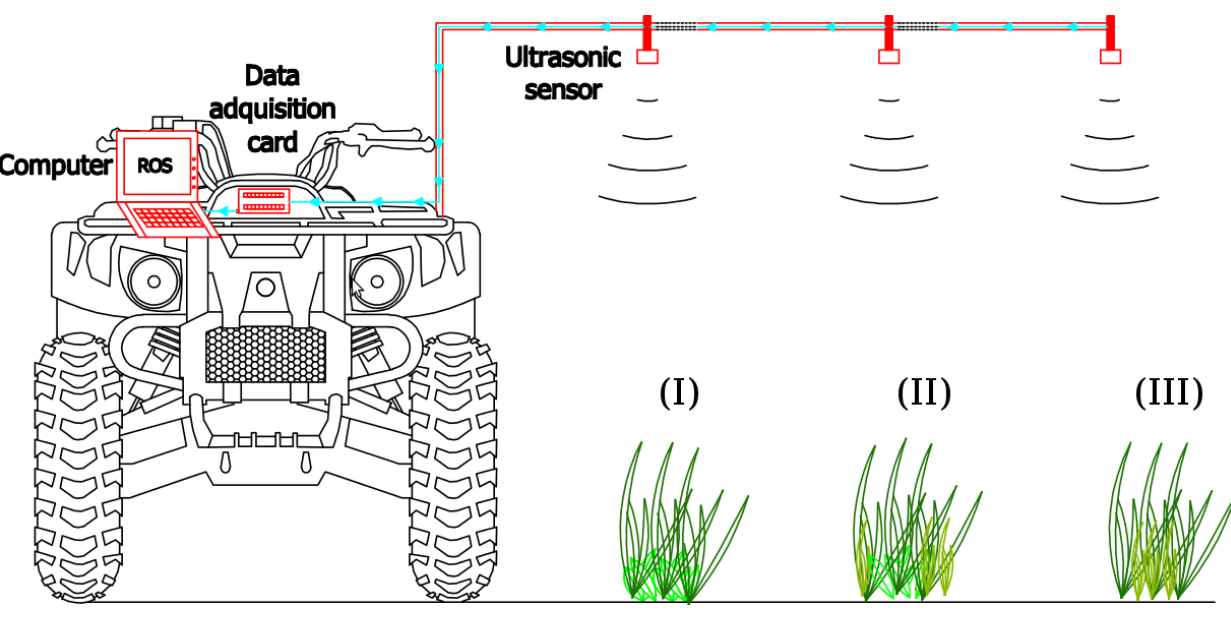
Figure 1. Schematic example for the ground-based ultrasonic system with the components for weed detection, working in three situations of weed–crop compositions: ( I ) crops and broad-leaved weeds; ( II ) crop and mixture of grasses and broad-leaved weeds; and ( III ) crop and grasses. Samples were taken while the vehicle was